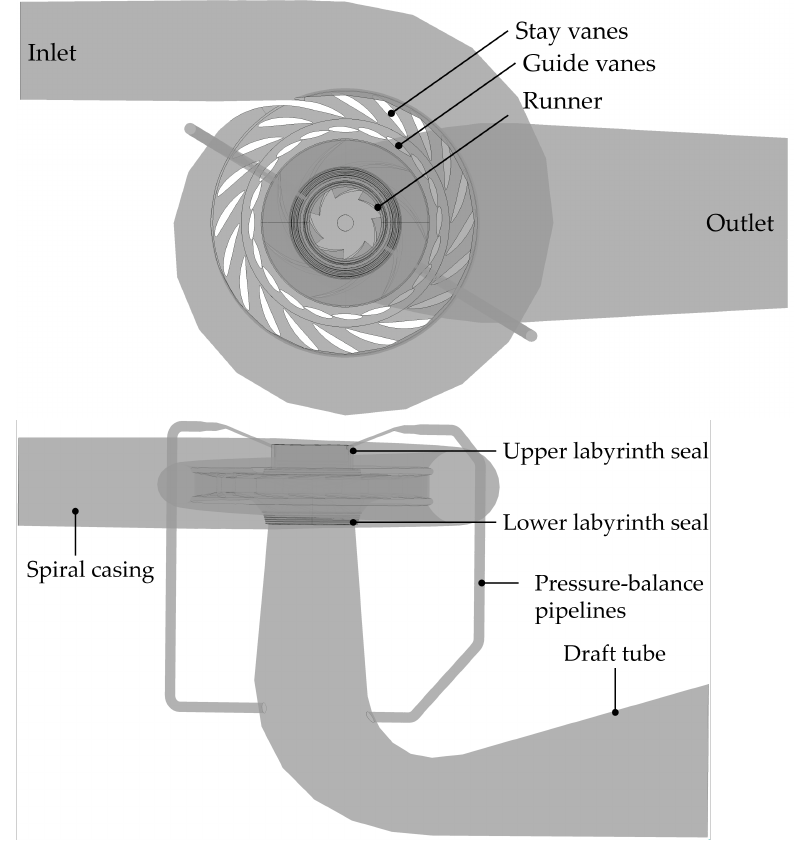
Figure 4. The 3D modeling of flow passage of the